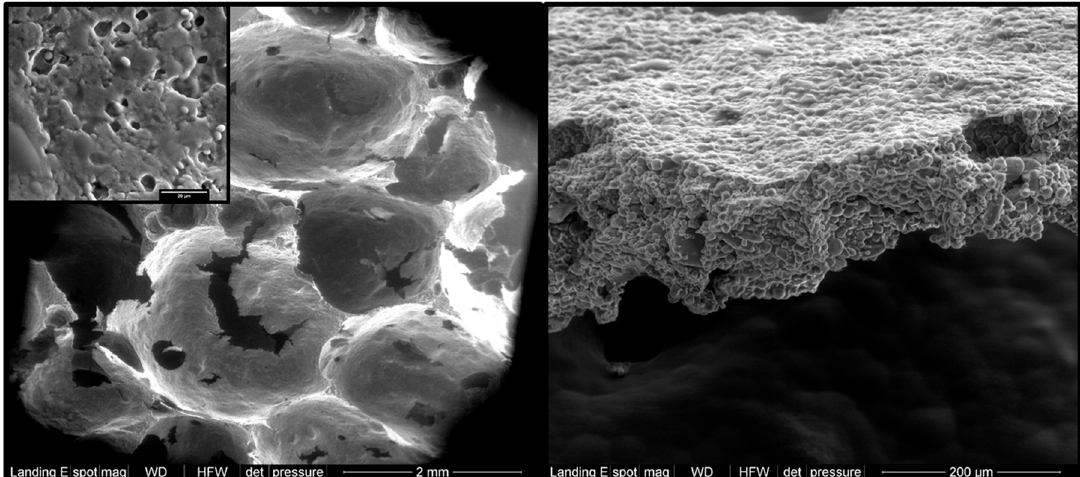
Figure 2. Micrographs of crumb (left) and crust (right) sections of breads containing 20% of RS2 banana starch. Detailed magnification (20 μ m) denotes the presence of some granules in the gelatinized